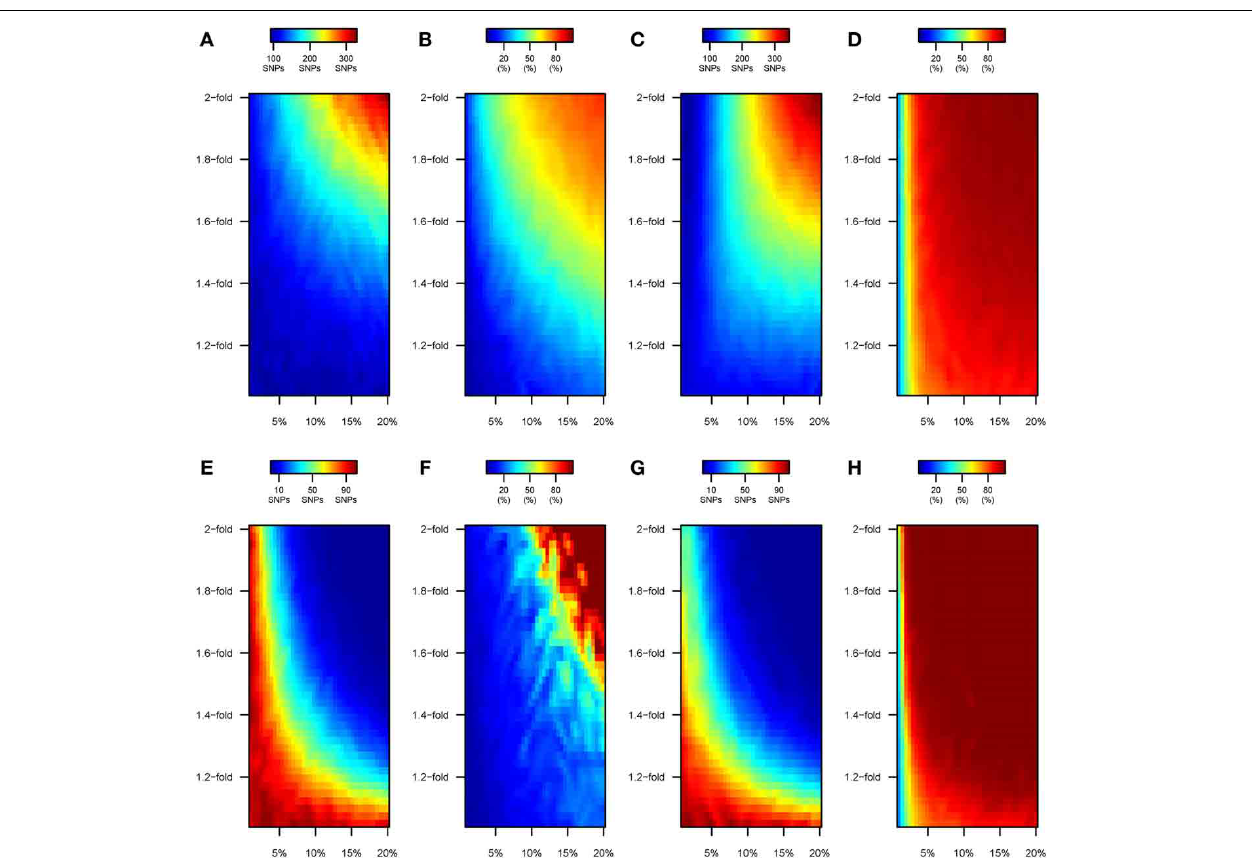
FIGURE 6 | Number of SNPs discovered by GWAS under scenarios B and C. Color maps showing the results of the GWAS upon cohorts of 100,000 individuals with (i) 100% of the samples drawn from the “modern” environment (scenario B; top panels, A–D ) and (ii) 50% of the samples drawn from each “ancestral” and “modern” environments (scenario C; bottom panels, E–H ). Specifically: (A,E) Under model 1, number of variants